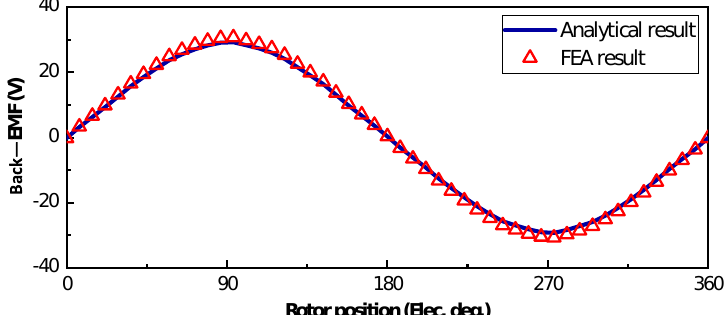
Figure 4. Comparison between FEA and analytical results of induced back-EMF.